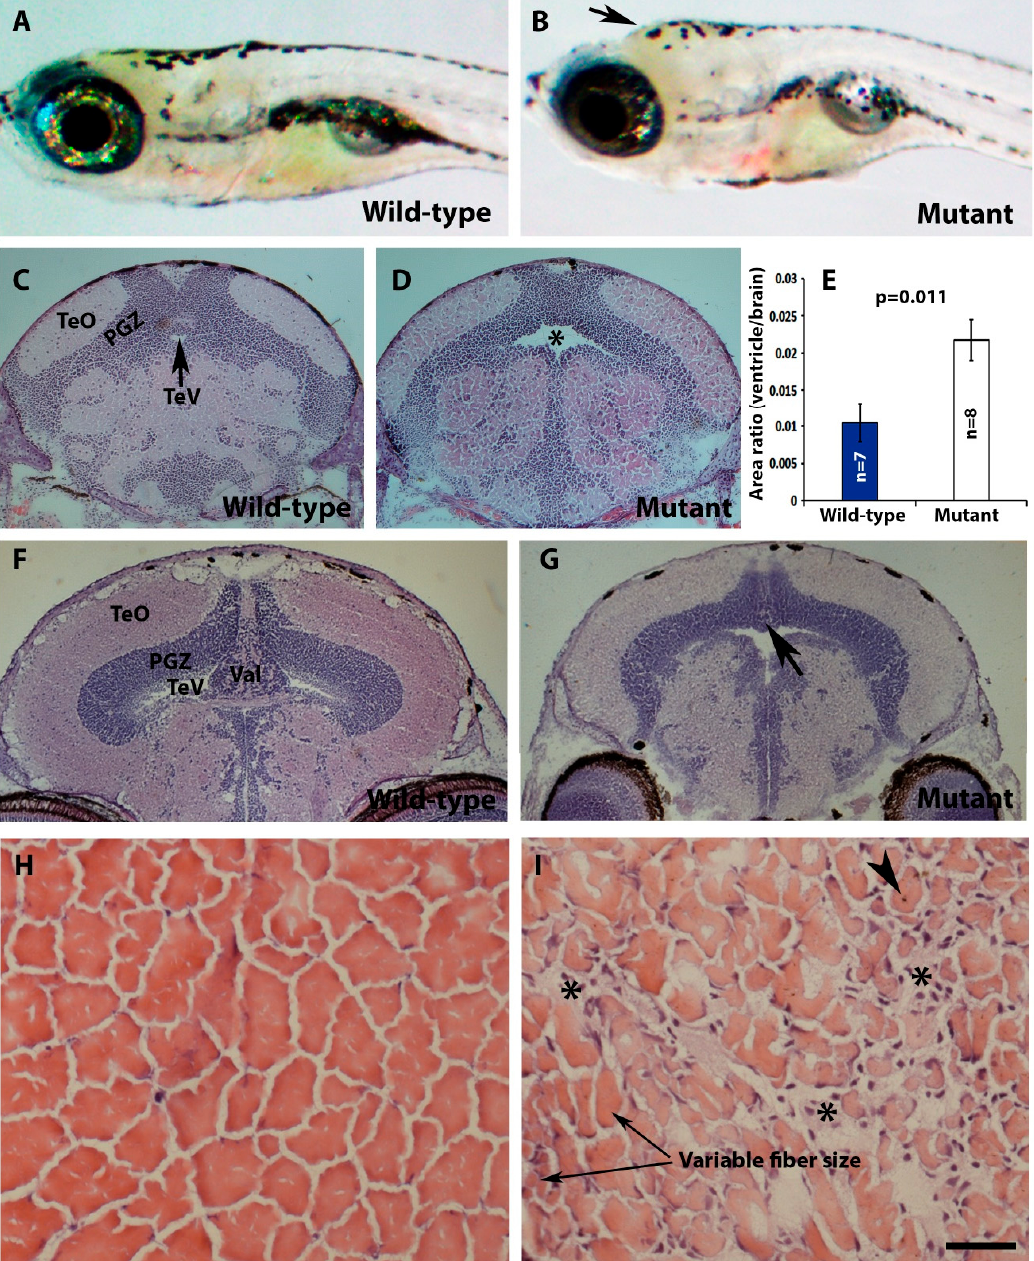
Figure 2. pomt2 mutant zebrafish exhibit hydrocephalus, hypoplasia of the cerebellum, and muscular dystrophy. Sections of the brain and skeletal muscle were stained with H&E. ( A , B ) Lateral view of a wild ‐ type and a pomt2 mutant zebrafish both dead 3 weeks post fertilization. Note the domed head in the mutant (arrow). ( C , D ) H&E staining of the rostral region of the optic tectum in zebrafish at 2 ‐ mpf. Note pomt2 mutant zebrafish showing an enlarged tectal ventricle (asterisk in ( D )). ( E ) Ratio of ventricular area to total brain cross ‐ sectional area. Note the increased ratio in the mutant. ( F , G ) H&E staining of the caudal region of the optic tectum in zebrafish at 2 ‐ mpf. Homozygous pomt2 sny5+13 mutant exhibited hypoplasia of the cerebellum (arrow). ( H , I ) H&E of skeletal muscle at 2 ‐ mpf. Note presence of dystrophic myofibers including necrotic fibers (asterisks), centrally located nuclei (arrowhead), and variably sized fibers. Scale bar in I: 50 μ m for ( C , D ), 60 μ m for ( F , G ), 28 μ m for ( H , I ). Abbreviations: TeO = tectum opticum; PGZ = periventricular gray zone; TeV = tectal ven ‐ tricle; Val = valvular cerebellum. 2.3. EYS protein Was Reduced and Mislocalized in the Pomt2 Mutant Retina Deletion of POMGnT1 in zebrafish resulted in mis ‐ localization of EYS protein in the retina [16]. Similarly, we evaluated EYS protein expression in pomt2 mutant retinas by immunofluorescence staining. In 1 ‐ mpf wild ‐ type retinas, anti ‐ EYS puncta were observed at the connecting cilium region of photoreceptors located at the basal end of acetylated α‐ tubulin immunoreactivity, as expected [13] (arrows, Figure 3A,C). However, in homozy ‐ gous pomt2 mutant retinas, EYS immunoreactivity was significantly reduced by 1 ‐ mpf (Figure 3B,D). The number of EYS immunoreactive puncta per 100 μ m retinal length was 15.68 ± 2.46 (Mean ± SEM) in the mutant retina, while the number for the wild ‐ type was 86.45 ±4.52 (Mean ± SEM) ( p < 0.0001, Student’s t ‐ test). In the wild ‐ type retina, most anti ‐ EYS puncta were located at the basal end of acetylated α‐ tubulin immunoreactivity. In the mutant retina, however, most of these puncta appeared to be within the outer nuclear layer (arrowheads in Figure 3B,D). To quantify this effect, acetylated α‐ tubulin ‐ immuno ‐ reactive axonemes associated with EYS puncta (Associated), acetylated α‐ tubulin ‐ immu ‐ noreactive axonemes without EYS puncta associated (Acetylated tubulin alone), and EYS puncta not associated with acetylated α‐ tubulin (EYS alone) were counted on confocal images captured from the dorsal and ventral retina at 1 ‐ mpf. The number of axonemes associated with EYS puncta, in homozygous pomt2 mutant retinas, were significantly re ‐ duced in numbers while the number of axonemes not associated with EYS puncta were significantly increased (Figure 3E). In pomt2 mutant retinas, the proportion of EYS not associated with acetylated α‐ tubulin was increased while the proportion of EYS associated with acetylated α‐ tubulin was decreased (Figure 3F). Similarly, the proportion of acety ‐ lated α‐ tubulin not associated with EYS was increased while the proportion of acetylated α‐ tubulin associated with EYS was decreased (Figure 3G). These results indicate that EYS protein is reduced and largely mis ‐ localized in pomt2 mutant retinas.